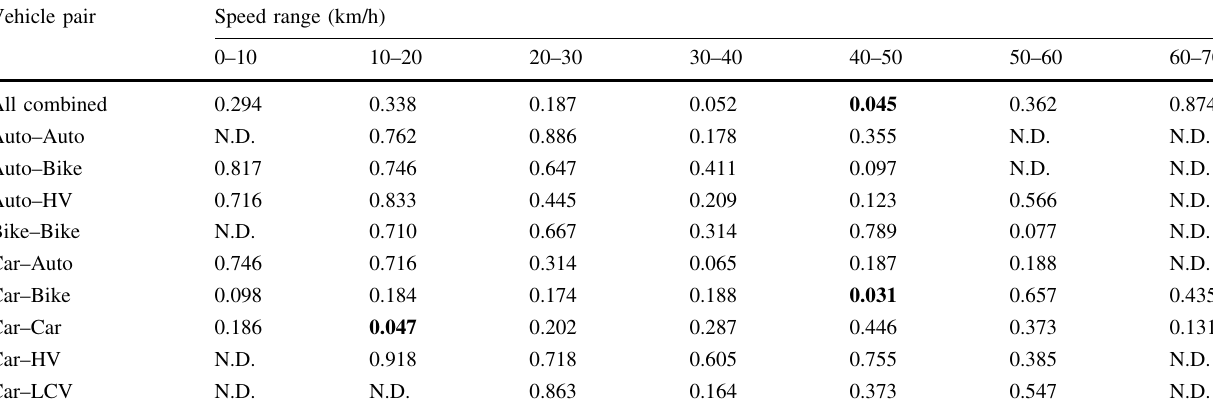
Table 6 Evaluation of means of field and model data at different speed intervals for different vehicle pairs Vehicle